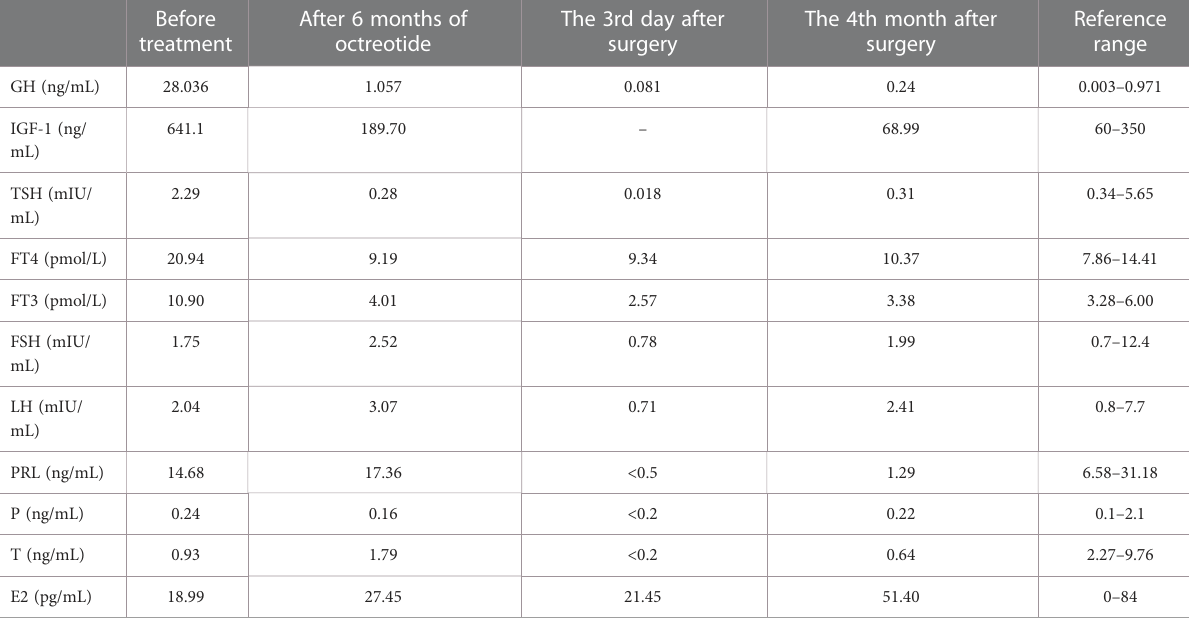
The 3rd day after surgery